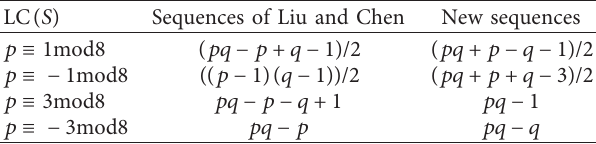
Table 2: Comparison of linear complexity LC ( S )